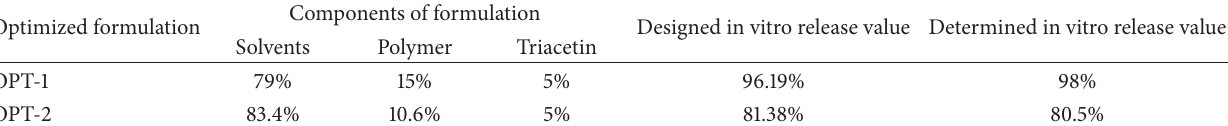
Table 7: Characteristics of optimized nail lacquer formulations.